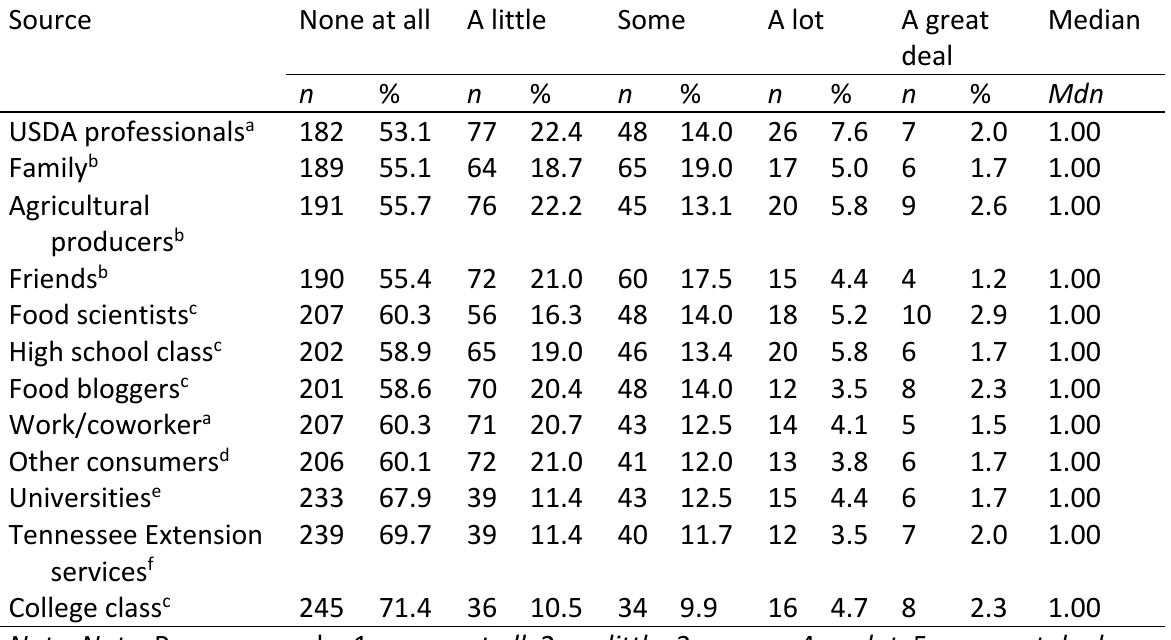
Information Source Use by Respondents with Neutral Perceptions of GMO Products (N = 343)